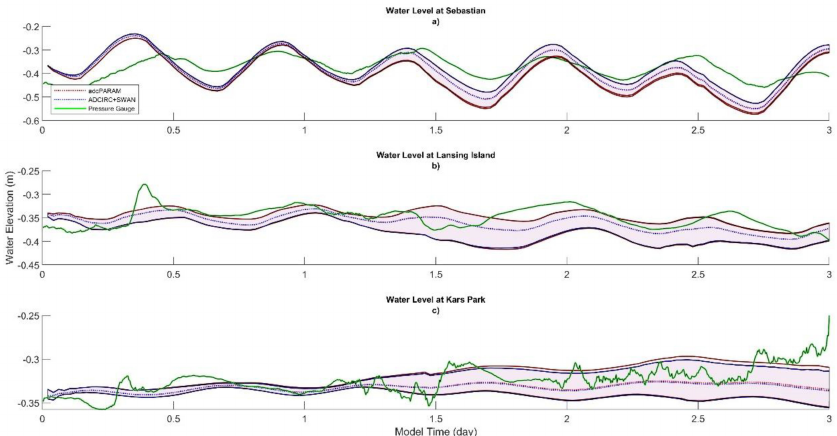
Figure 12. Time series plots of ADCparam and ADCIRC + SWAN ensemble range for water elevation and 50-min moving average of in-situ data (meters) with geoid offset near ( a ) Sebastian, ( b ) Lansing Island, and ( c ) Kars Park. Pressure sensor station locations are specified in Figure 8. Dotted lines represent the average solution across the full ensemble, while upper and lower bounds of shaded areas represent the maximum and minimum values of the whole